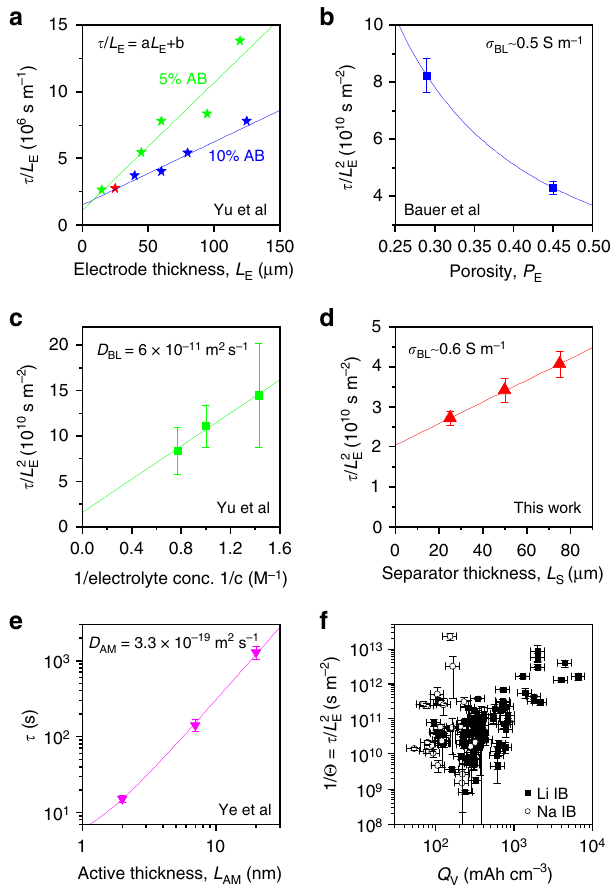
versus L E for Fig. 5 Further testing of the terms in Eq. (6a), (6b). a τ = L E electrodes with 5% and 10% acetylene black, and so different conductivities (extracted from ref. 16 ). This results in different a parameters (slopes) but the same b parameter (intercept), consistent with Eq. (6a), (6b). b τ = L 2 versus porosity extracted from ref. 19 . The line is a fi t to Eq. (9) E and yields a value of σ BL close to the expected value (see panel). c τ = L 2 E versus inverse electrolyte concentration extracted from ref. 16 . The line is a fi t to Eq. (10) and yields D τ = L 2 BL close to the expected value (see panel). d E versus separator thickness (this work). The line is a fi t to Eq. (11) and yields σ BL close to the expected value (see panel). e Characteristic time versus the thickness of a thin active layer (TiO 2 ) extracted from ref. 12 . The line is a fi t to Eq. (12) and yields a diffusion coef fi cient for Li ions in anatase TiO 2 close to the expected value 85 . f 1/ Θ plotted versus the intrinsic volumetric electrode capacity, Q V , for cohorts I and II showing the scaling predicted by Eq. (13a). All errors in this fi gure are fi tting errors combined